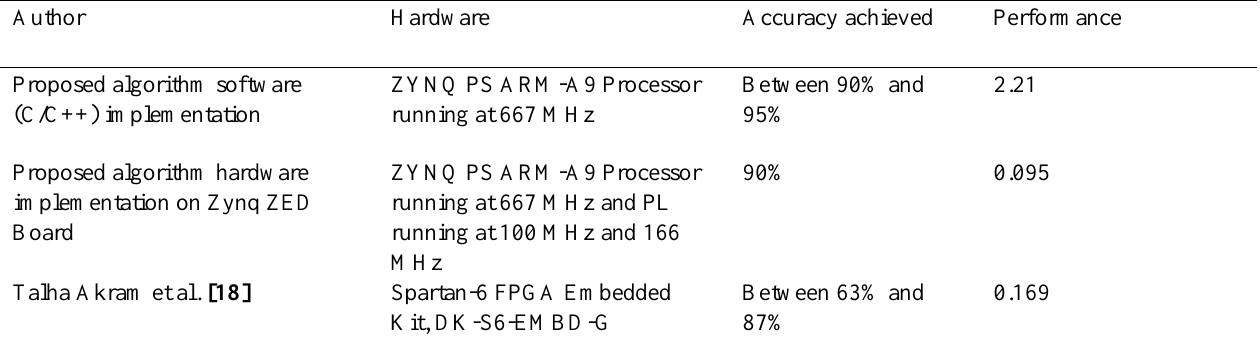
Proposed algorithm hardware implementation on Zynq